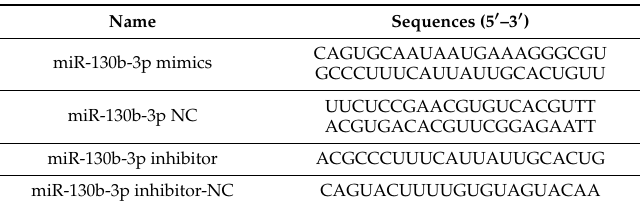
Table 2. Sequences of RNA